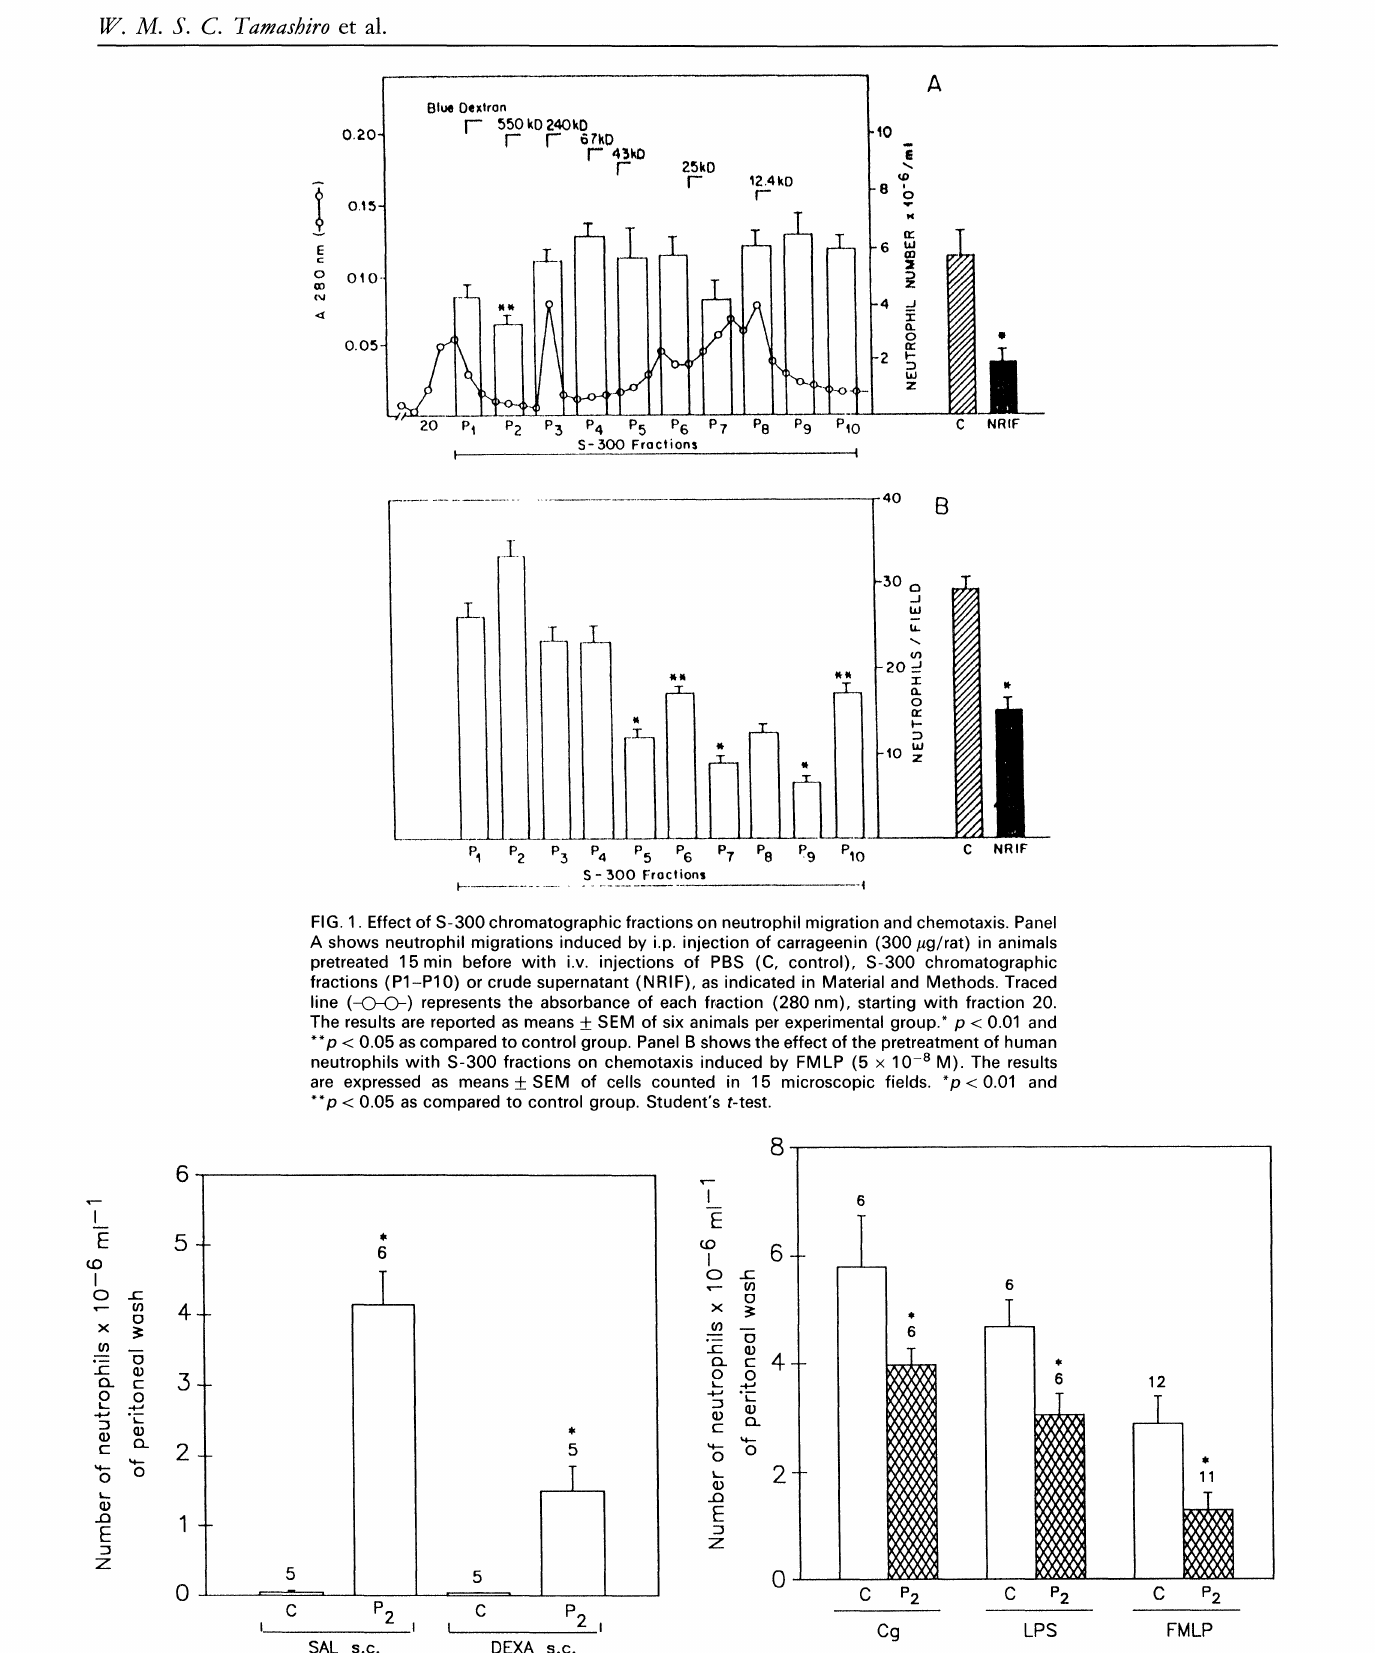
DEXA s.c. FIG. 3. Inhibitory effect of P2 fraction upon neutrophil migration induced FIG. 2. Detection of MNCF activity in P2 fraction. The bars represent by different inflammatory stimuli. Bars represent neutrophil migrations neutrophil migration into peritoneal cavities induced by either saline (C, induced by i.p. injections of carrageenin (Cg, 300 #g), LPS (5 ng) or FMLP (130 ng), in animals pretreated with i.v. injection of P2 fraction. control) or P2 fraction, in either saline or dexamethasone (0.5 mg kg -1, s.c., h before) pretreated animals. The results are reported as The results are reported as means___ SEM of the number of animals means -I- SEM of the number of animals indicated up each bar. *p < 0.01 indicated up each bar. *p < 0.05 as compared to control group. Student’s as compared to control. Student’s t-test.